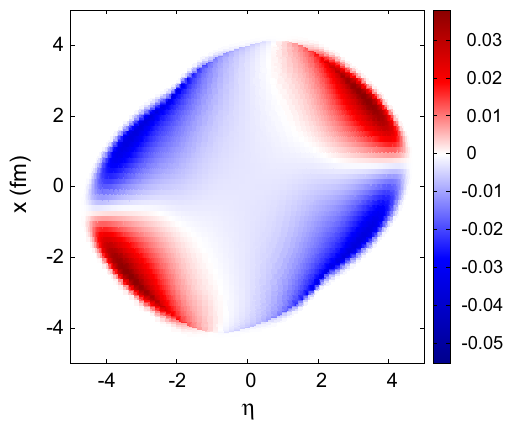
Fig. 13 Contour plot of 1 /τ -scaled η x covariant component of the thermal vorticity, (cid:6) η x /τ over the freeze-out hypersurface for y = 0, η/ s = 0 . 1, η = 2 . m